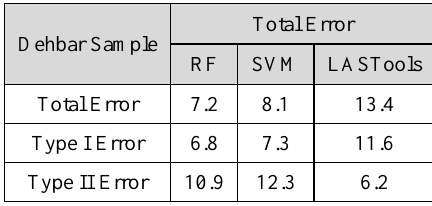
Table 3: A comparison between the accuracies obtained by the proposed method and LAStools on Dehbar